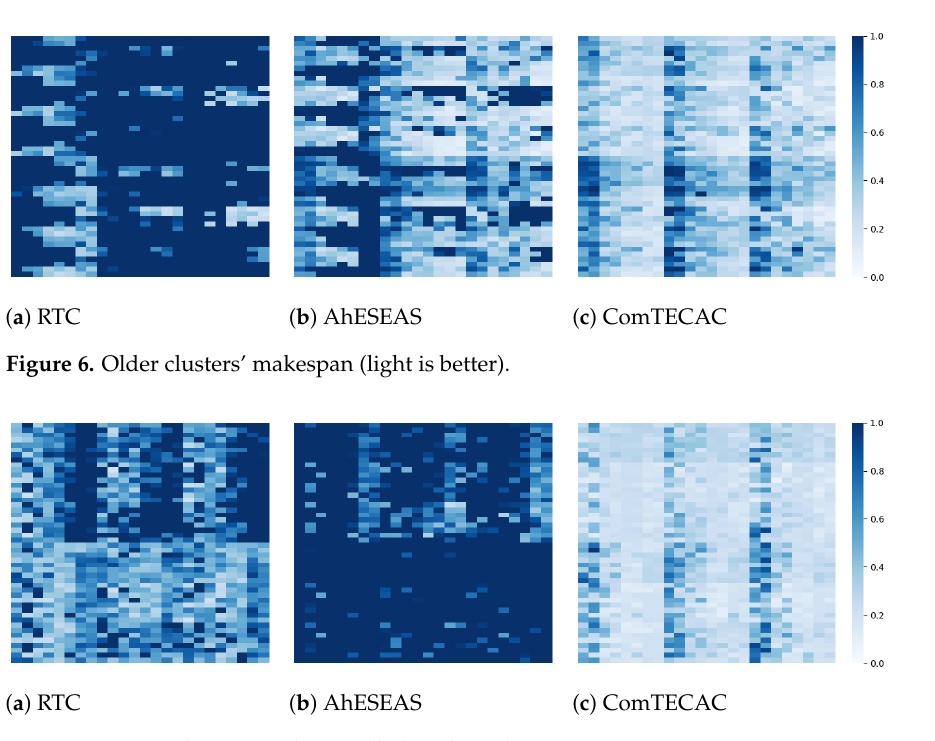
Figure 7. Recent clusters’ makespan (light is